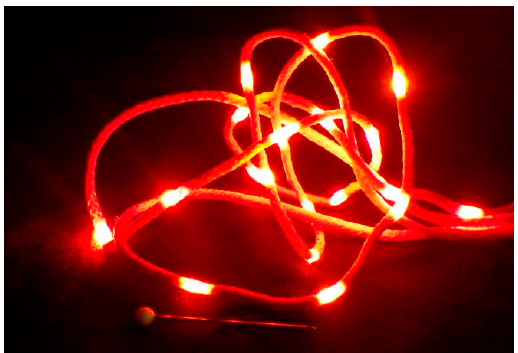
Figure 1. Illuminated light emitting diode (LED)-yarn shown next to a 30 mm long pin.